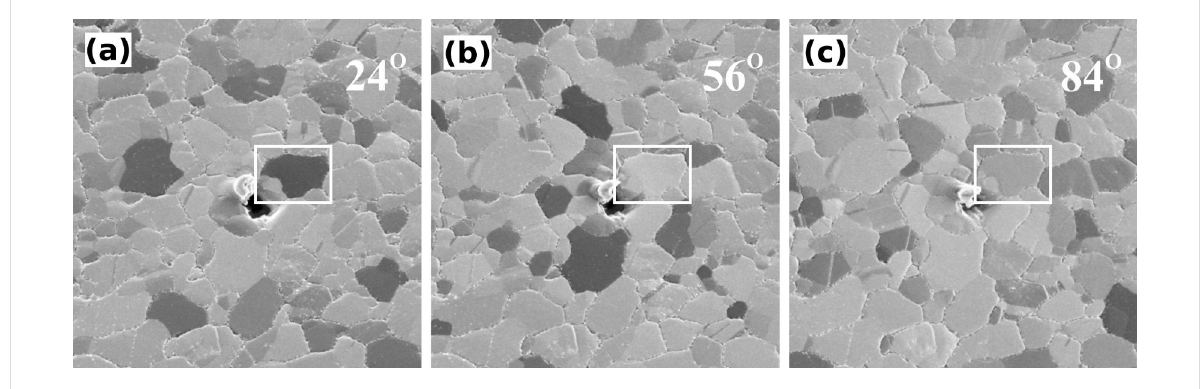
Figure 1: HIM SE images of the hydrogen-flame-annealed polycrystalline Au{111} film taken with a PE of 15 keV and an ion dose of 4.9 × 10 14 cm − 2 . Relative sample rotation angles around the surface normal are 24°, 56° and 84°. The polar angle is fixed at 35°. FOV: 10 µm.